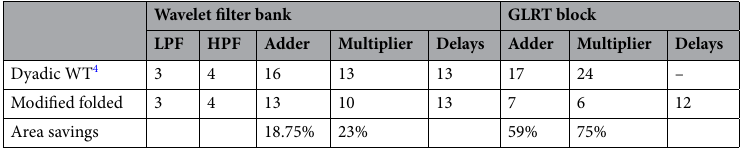
Table 8. Comparison of GLRT based ECG detector.